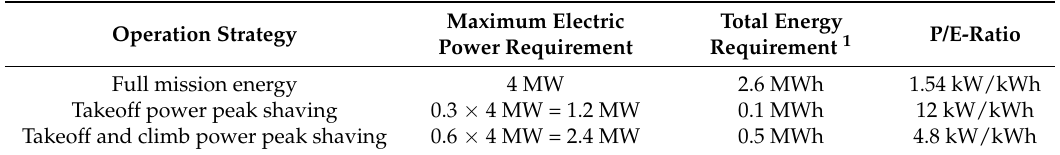
Table 3. P/E-ratio specifications of different operation